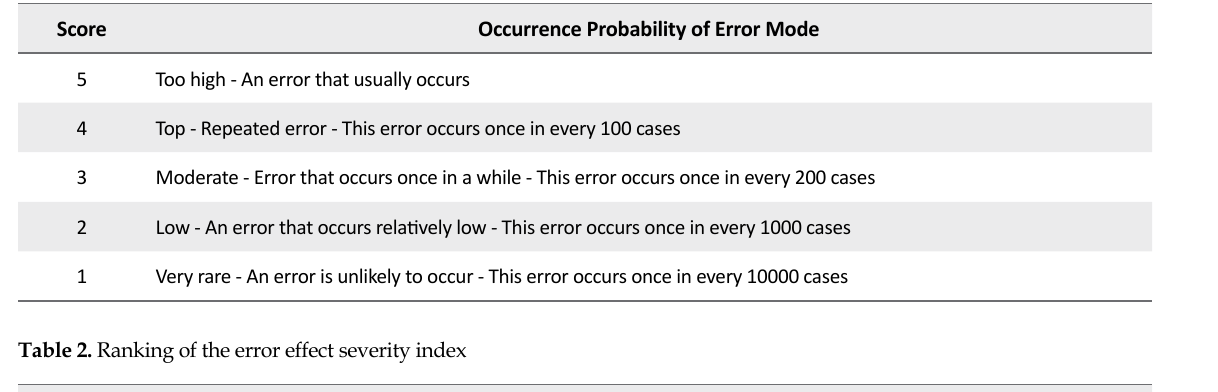
Table 1. Ranking of error probability occurrence Score Occurrence Probability of Error Mode